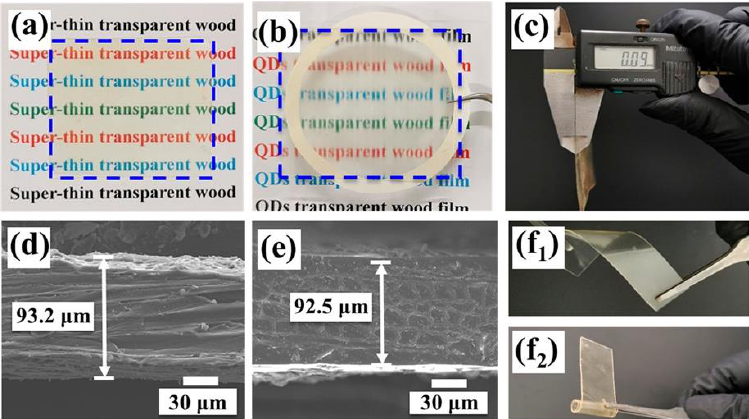
Figure 12. ( a , b ) Superthin transparent wood films placed directly on substrate and 10 mm above the substrate, respectively. ( c ) Thickness of the superthin transparent wood films measured with vernier calipers. ( d , e ) Thickness of superthin transparent wood films confirmed by SEM. ( f 1 , f 2 ) The flexibility of a transparent wood film, rolled in different directions. Reprinted with permission from [37], copyright 2022, American Chemical Society.